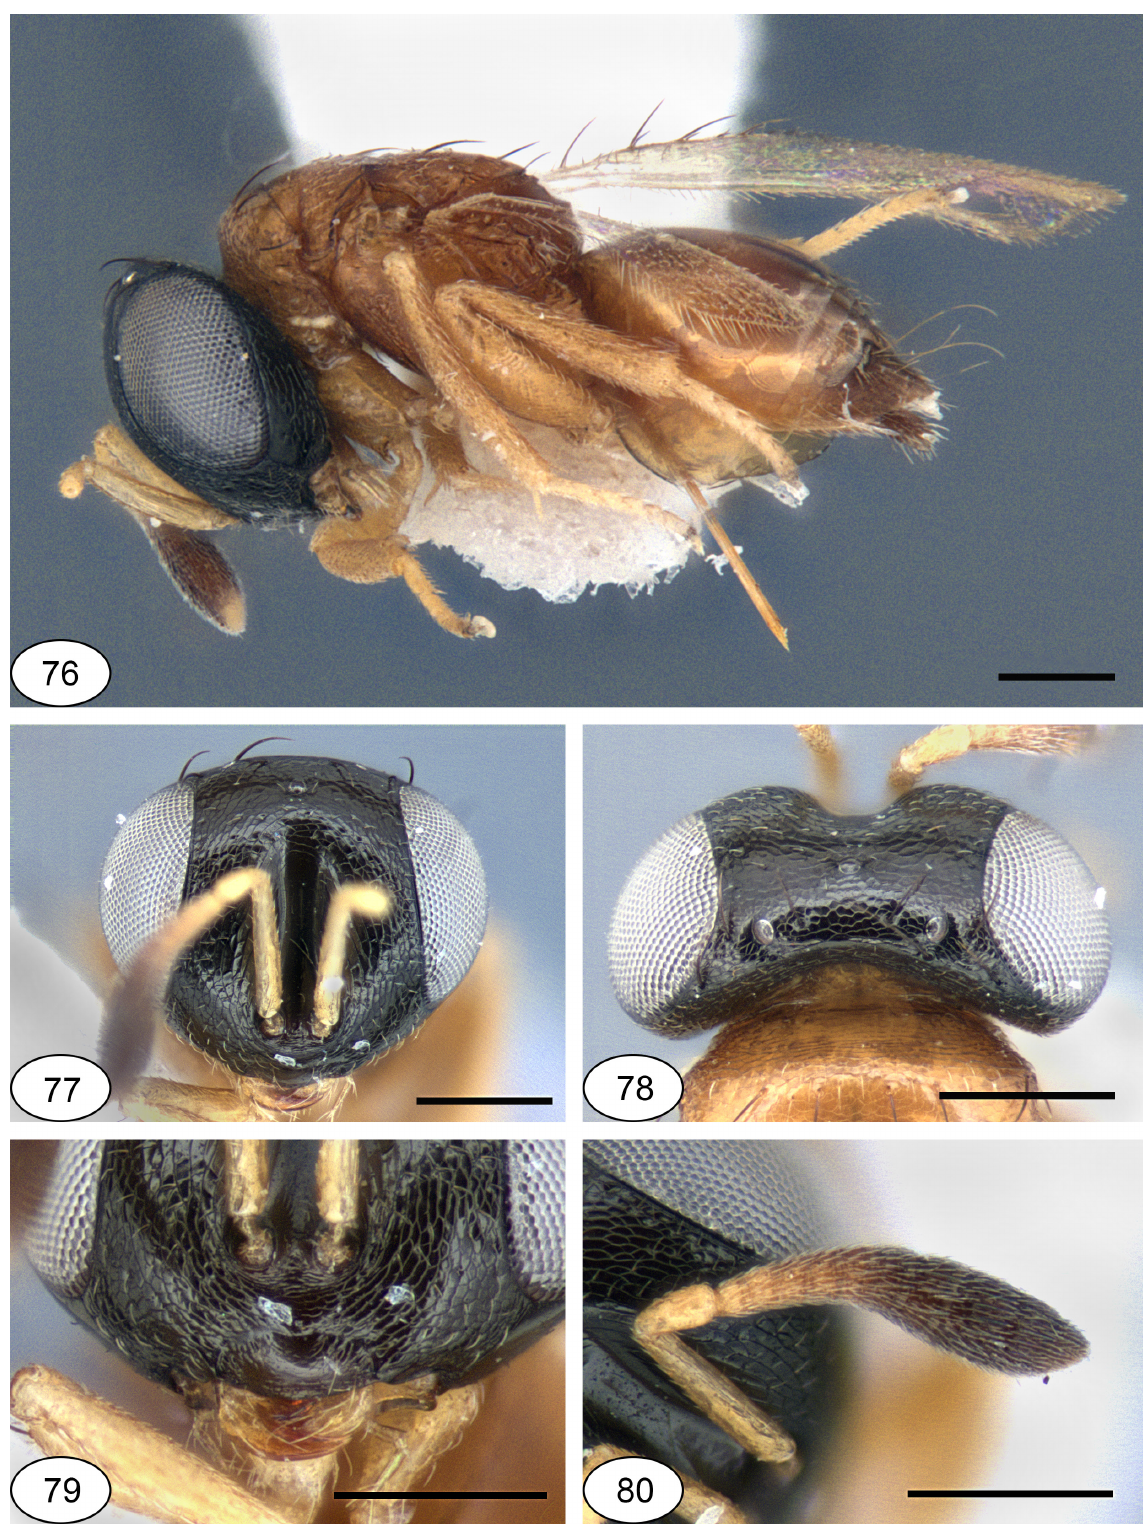
Figs 76–80. Netomocera gloriosa sp. nov., holotype, ♀ . 76 . Habitus, lateral view. 77 . Head, frontal view. 78 . Head, dorsal view. 79 . Lower face. 80 . Antenna. Scale bars: 0.2